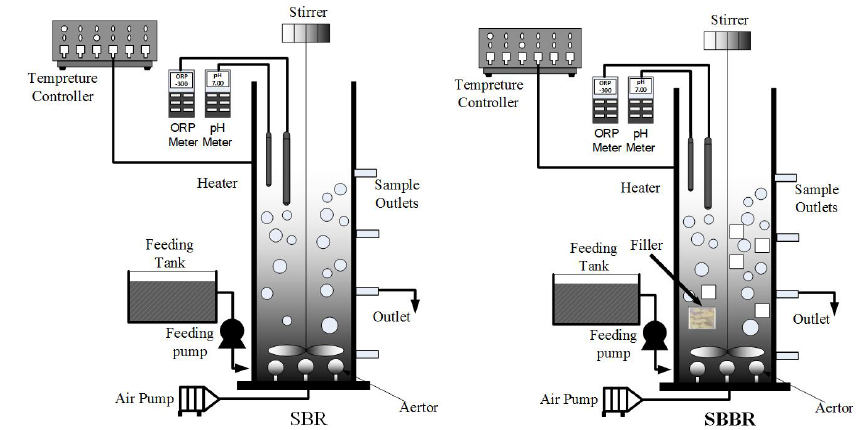
Figure 1. Schematic diagrams of the SBR and SBBR device.